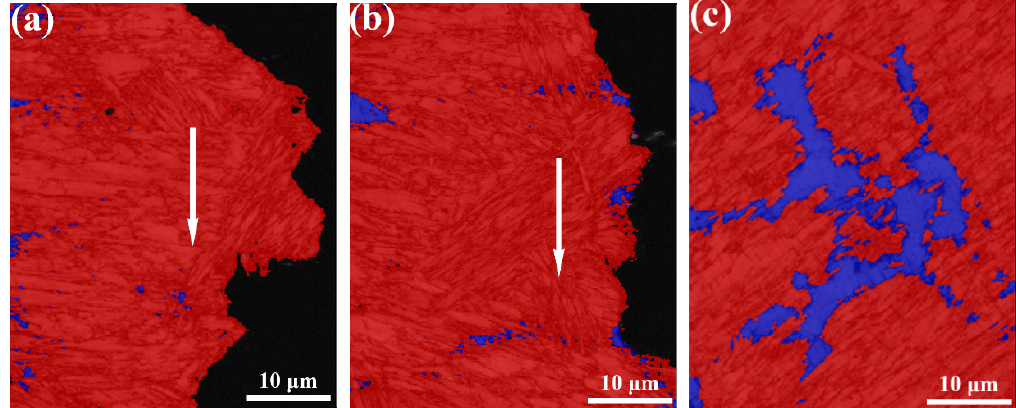
Figure 14. Phase map superimposed on band contrast map; ( a ) Crack initiation area in the weld metal; ( b ) Crack propagation area in the weld metal; ( c ) Deformation-free area in the weld metal. Note: Red and blue represent martensite and austenite, respectively. The white arrow represents the crack path.